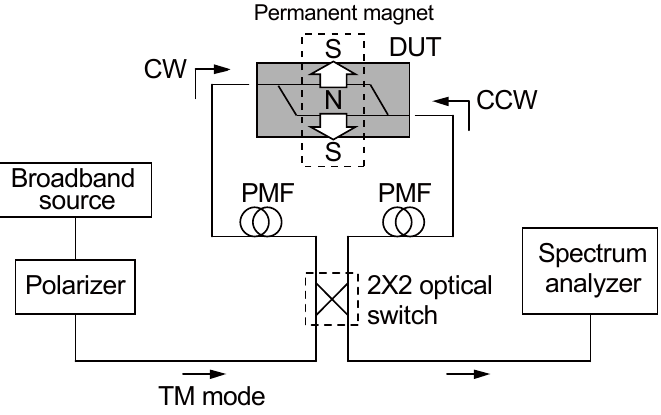
Figure 6. The measurement setup for the fiber-to-fiber transmittance of a waveguide optical isolator [46]. PMF: polarization maintaining